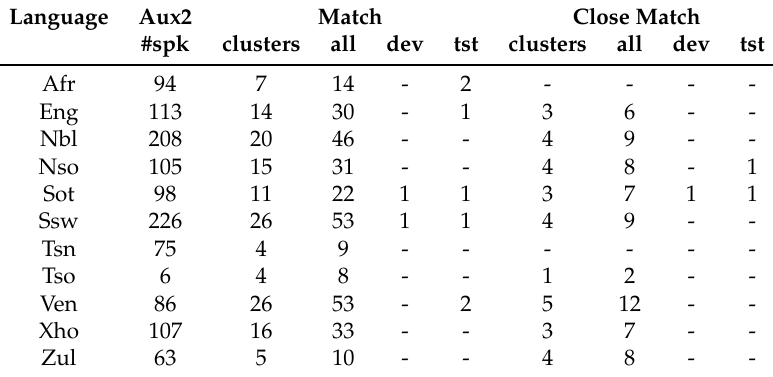
Table 6. Claimed speaker overlap for matching and close matching metadata fields (names, ID,